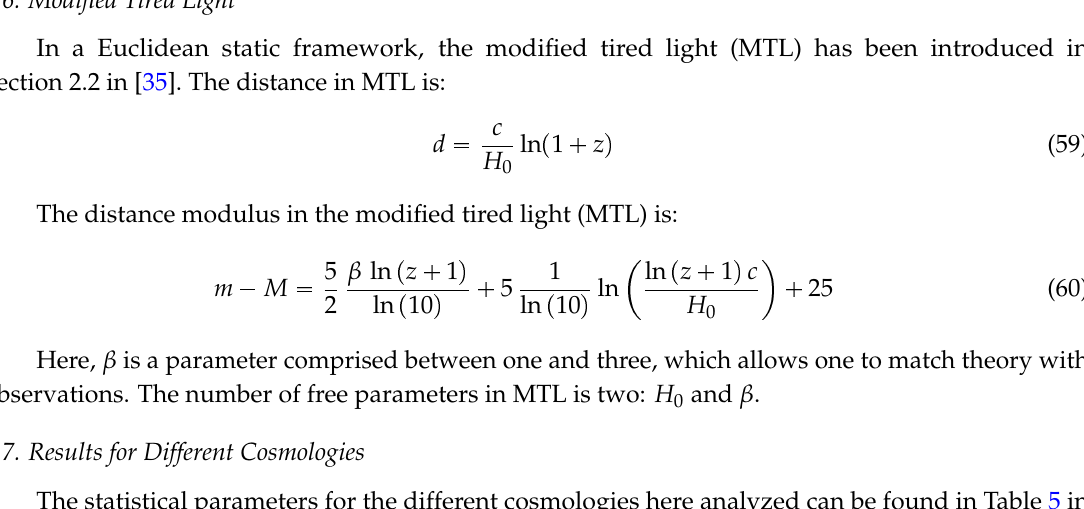
Table 5. Numerical values of χ 2 , χ 2 , Q and the AIC of the Hubble diagram for the Union 2.1 red compilation; k stands for the number of parameters; H 0 is expressed in kms (cid:1) 1 Mpc (cid:1) 1 .